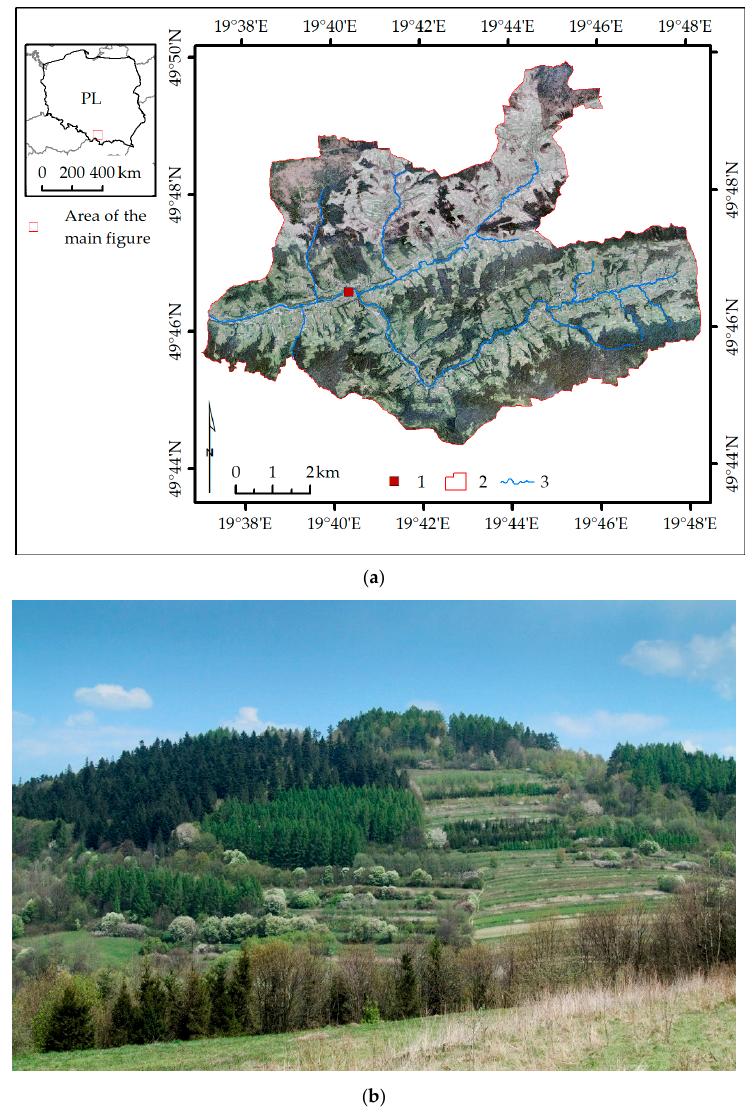
Figure 1. Study area. ( a ) Budzów community is located in the south of Poland in the Carpathians: 1— administrative center of Budzów community, 2—villages boundaries, and 3—rivers, against orthophotomap from 2009. ( b ) Photograph of a typical highly fragmented forest-agricultural landscape in Budzów community, taken 28 April 2008 (by K. Ostafin); various stages of forest succession are clearly